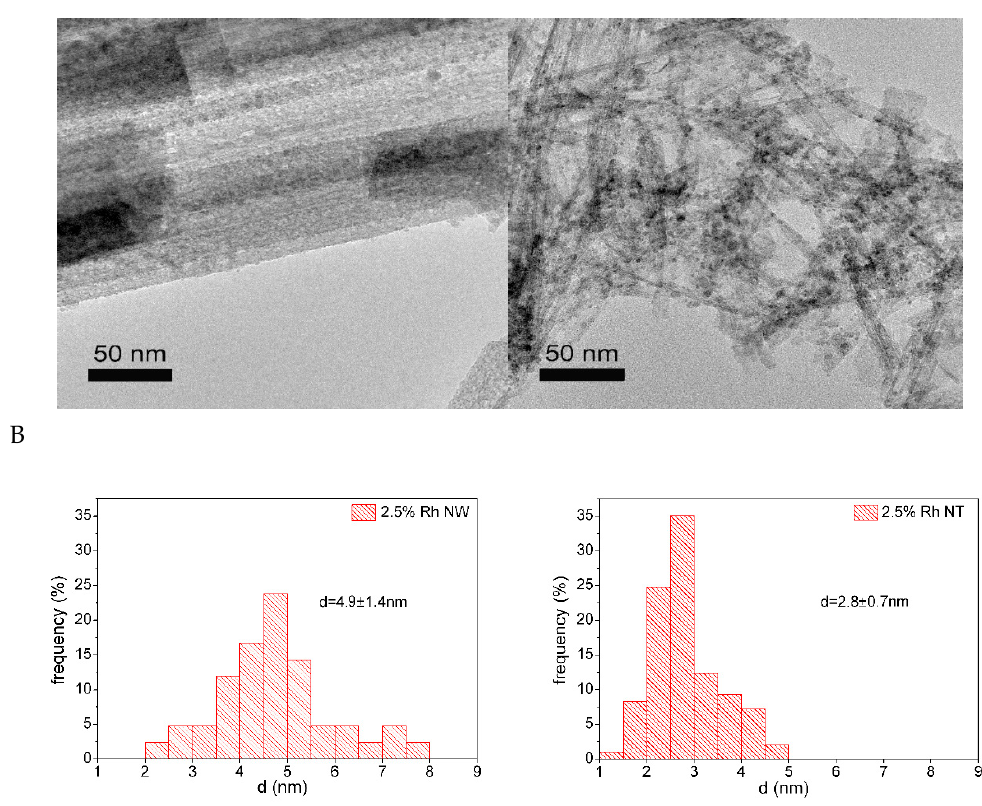
Figure 3. Typical TEM images of 2.5% Rh decorated titanate nanowires ( A ) and titanate nanotubes ( B ) thermally annealed at 673 K and the corresponding size distribution of Rh nanoparticles. Reproduced from